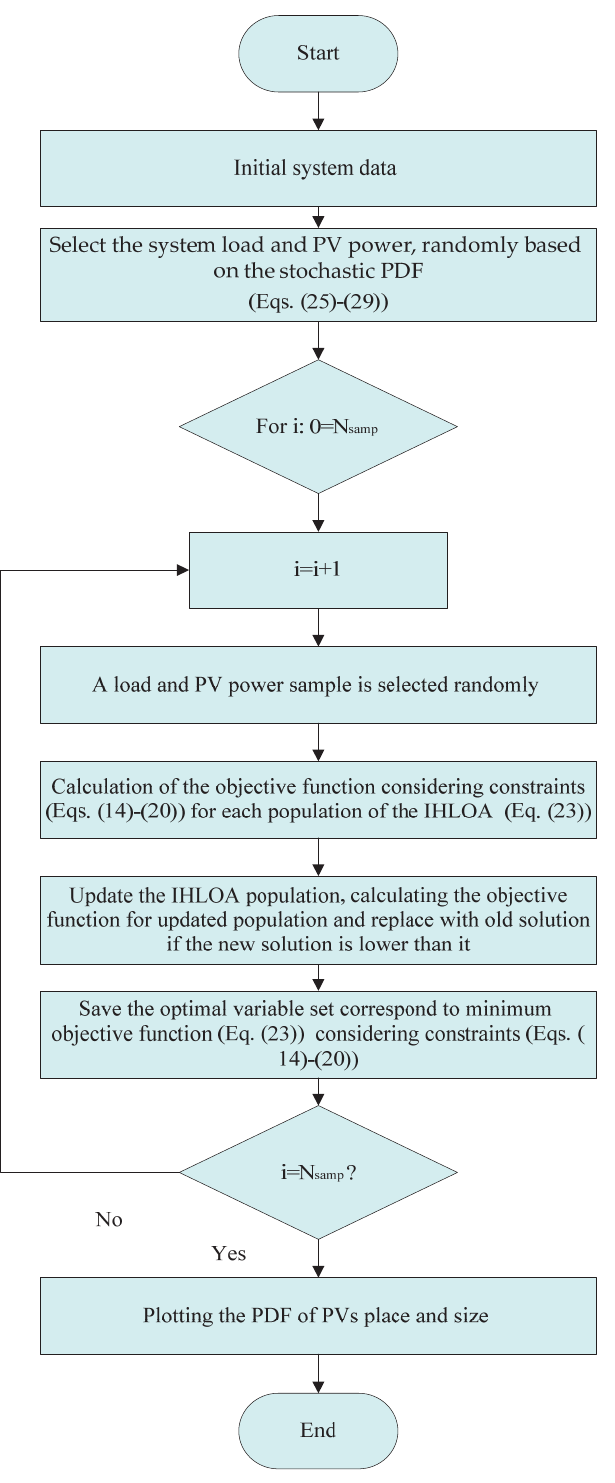
Figure 3. Flowchart of stochastic–metaheuristic model for PVs allocation using the IHLOA.